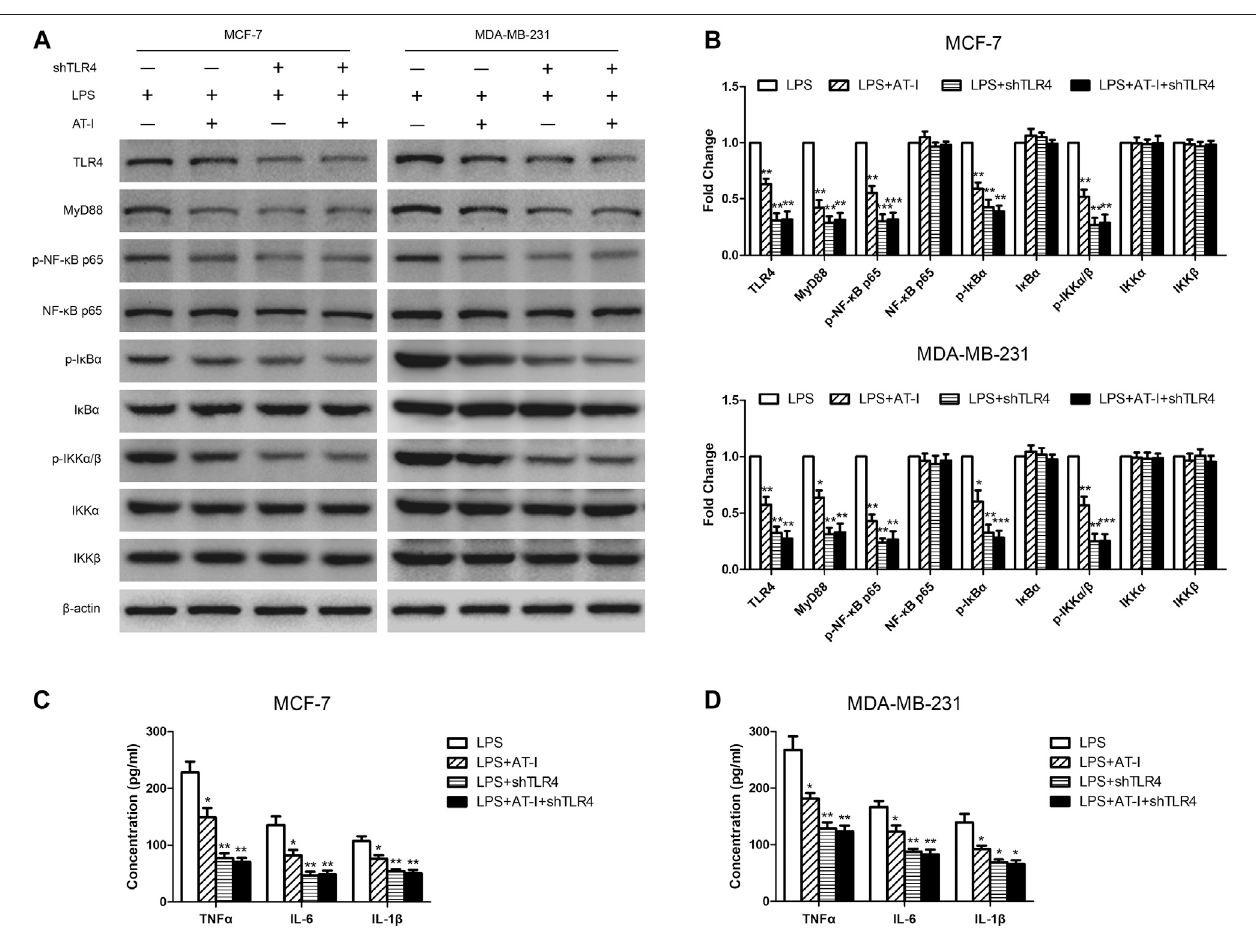
FIGURE 5 | The effects of AT-I on suppressing tumorigenesis was mediated by TLR4. The shTLR4 plasmid was used to transfect breast cancer cells, and then western blot and ELISA assays were used to compare related proteins expression with untransfected cells after cells had been pre-treated in presence or absence AT-I for 48 h during LPS stimulation. (A, B) The expression ofTLR4/NF- κ B signaling pathway was detected bywestern blot assay. (C, D) Thelevels ofTNF- α , IL-6 and IL-1 β in the cell supernatants were measured by ELISA assay. Signi fi cant differences between different groups were indicated as * p < 0.05, ** p < 0.01, *** p < 0.001, vs. the LPS treated control group, n (cid:1)